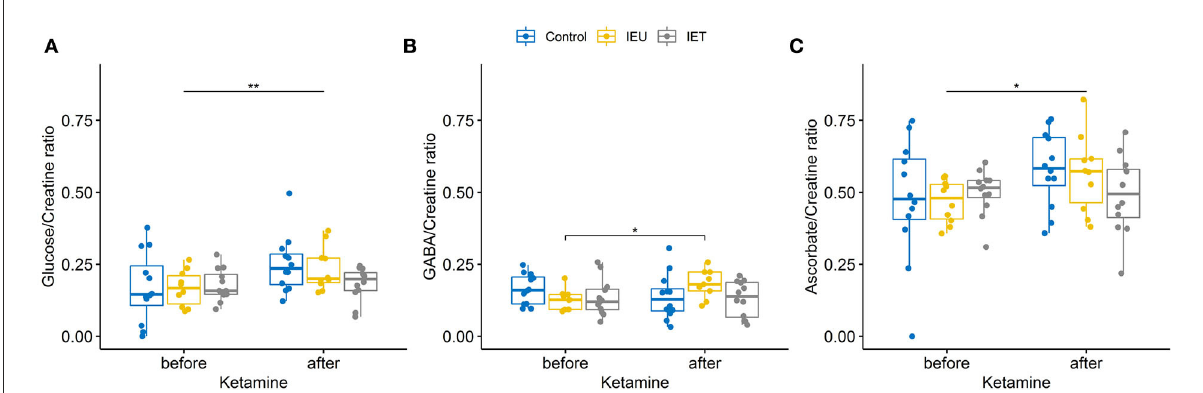
FIGURE2 (A–C) Boxplot of thalamic metabolite concentrations [ (A) glucose, (B) GABA, (C) ascorbate] prae and post ketamine relative to creatine in healthy control dogs (blue), dogs affected by idiopathic epilepsy without antiepileptic drug treatment (IEU in yellow) and treated epileptic dogs (IET in gray). (A) Ketamine increased glucose/creatine ratios significantly ( p < 0.001) but no effect of group allocation was found. A trend for an interaction between group allocation and ketamine administration was observed [p = 0.065, (A) ]. (B) For GABA/creatine ratios no significant effects of ketamine administration ( p = 0.544) or group allocation ( p = 0.525) were found, however there was a significant interaction between group allocation and ketamine administration [ p = 0.038, (B) ]. post-hoc tests revealed a significant increase after ketamine for group IEU ( p